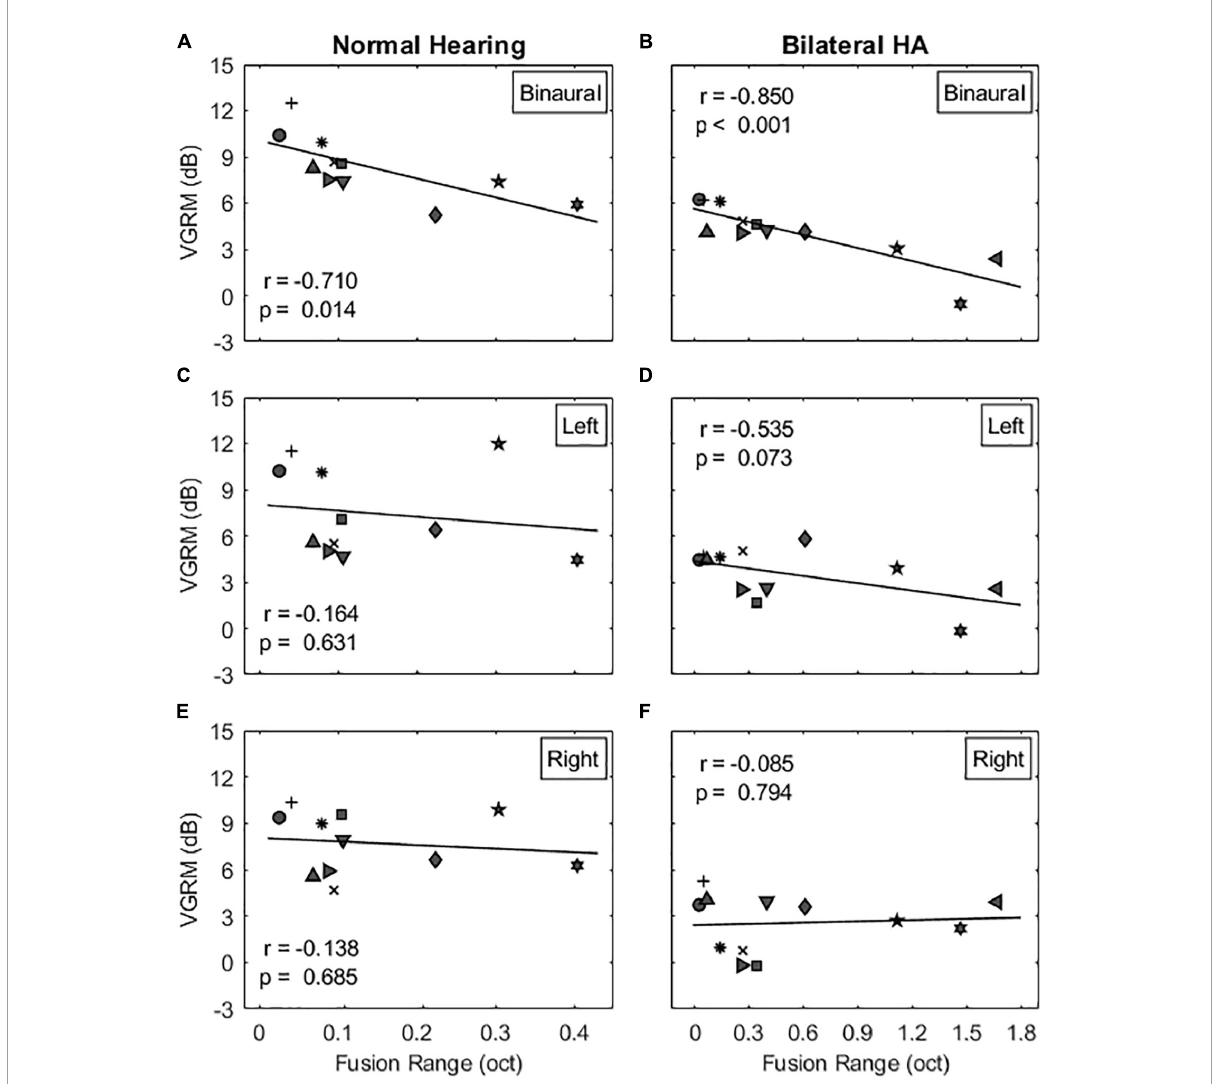
FIGURE5 Correlations between voice gender release from masking (VGRM) and binaural pitch fusion range for the co-located target-maskers configuration. The left and right columns show the correlation results for NH and bilateral HA user groups, respectively. The panels (A–F) show the correlation results for the binaural, left, and right listening conditions, respectively. Table 2 shows the correlation results for the spatially separated target-maskers